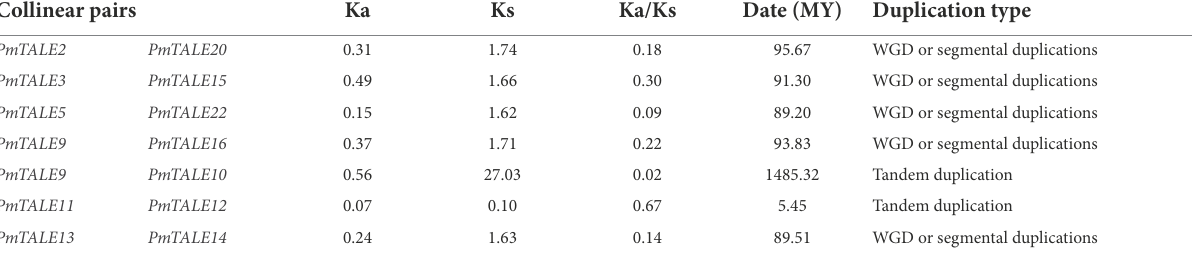
TABLE 2 Ka/Ks value calculation and evolution time prediction of collinear pairs within the Prunus mume TALE gene family. Collinear pairs Ka Ks